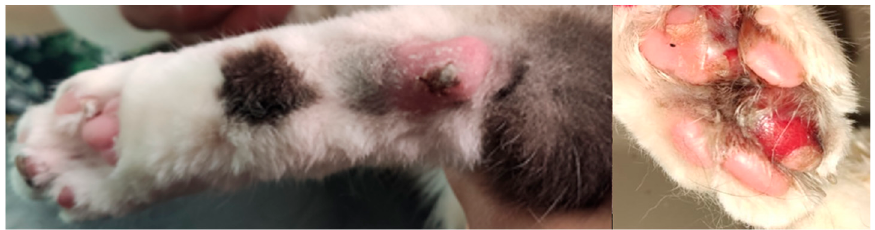
Figure 1. Severe ulcerative and necrotizing pododermatitis with serocellular crusts. At the time of admission, a moderate lymphocytopenia (0.59 K/ μ L; reference interval